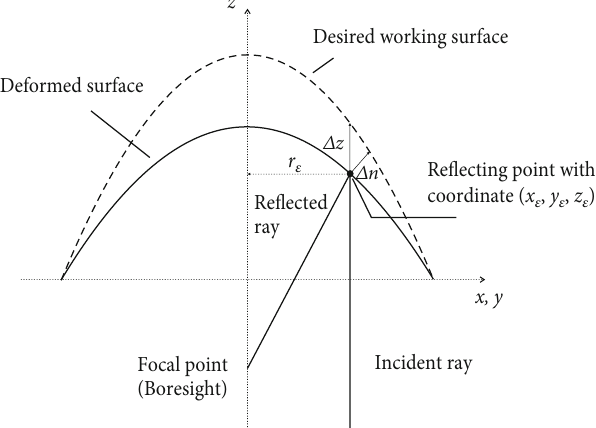
Figure 2: Geometric information of surface deviations in the z -direction and in the direction normal to the re fl ecting